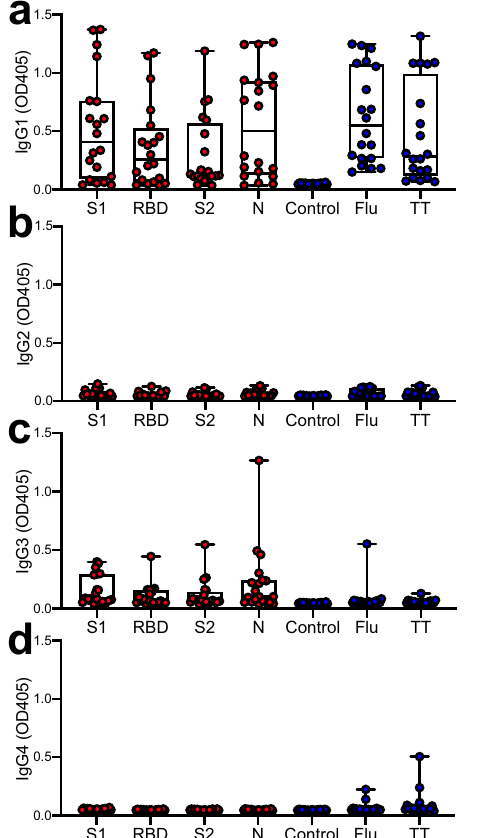
Fig. 2 Analysis of IgG subclasses in seropositive patients. Analyzing plasma samples from 20 patients with COVID-19 for IgG responses against the four SARS-CoV virus proteins S1, RBD, S2, and N in an ELISA we found that these responses primarily consisted of the a IgG1 and c IgG3 but not the b IgG2 and d IgG4 subtypes. Full-length GST protein was used as a negative control and Flu and TT proteins served as positive controls. Boxplots extend from the 25th to 75th percentiles, the line indicates the median, and whiskers indicate the